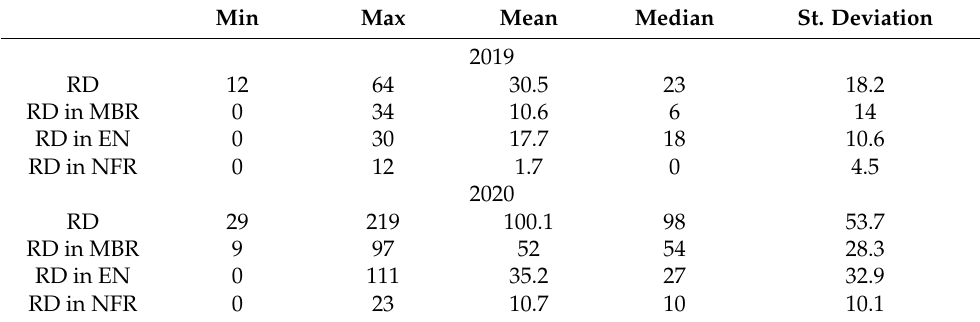
Table 3. Descriptive Statistics in 2019 and